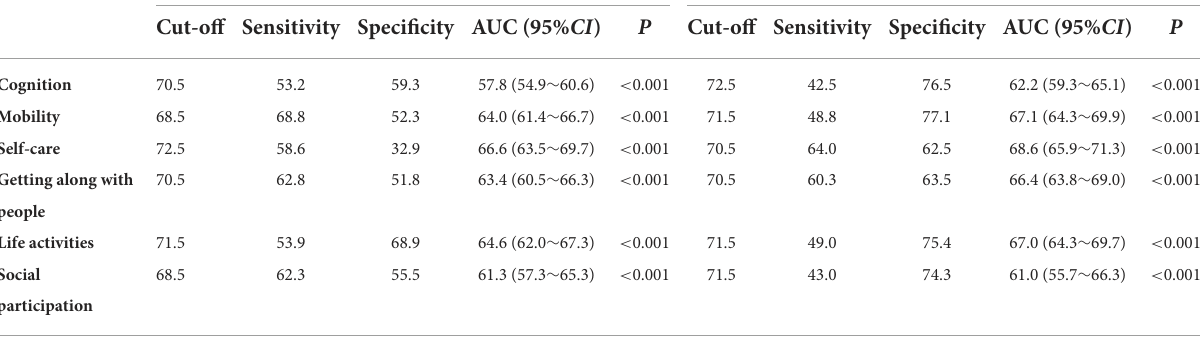
TABLE 2 Gender specific cut-off points of age for disability. Male